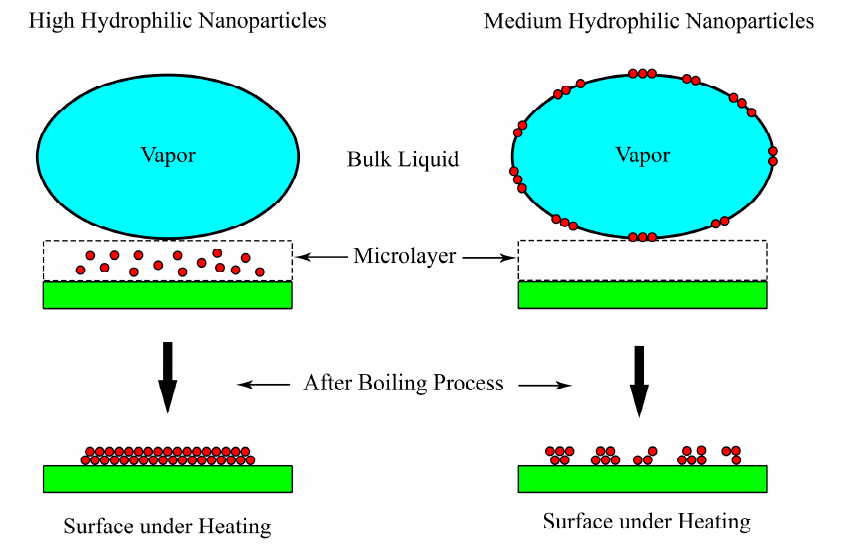
Figure 5. Illustration of nanoparticle wettability effect on deposited layer morphology. Adapted from Quan et al.. Reproduced from [138], Elsevier: 2017.